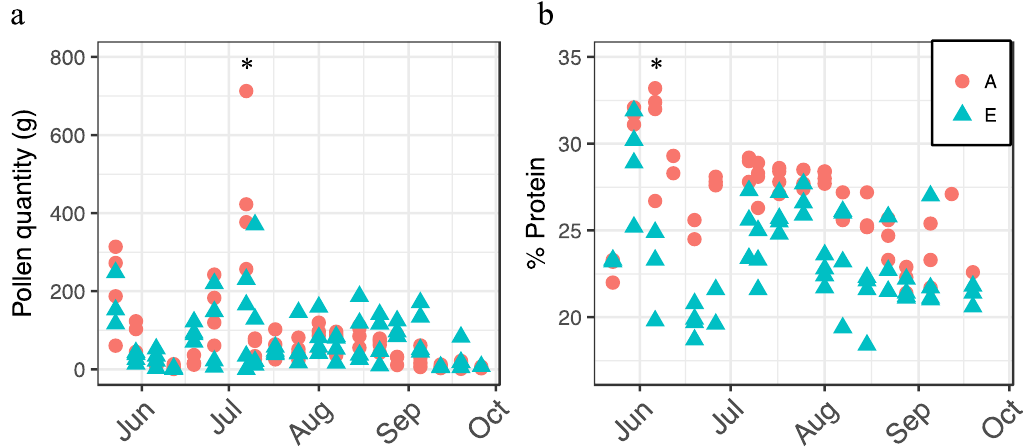
Figure 3. Pollen collection ( a ) and crude protein (percent dry weight) content ( b ) by apiary site (A = circles, E = triangles) and date, 2014. Asterisks denote significant dates on which responses differed between apiaries as determined by analysis of variance (ANOVA) and Tukey's honest significant difference (HSD).